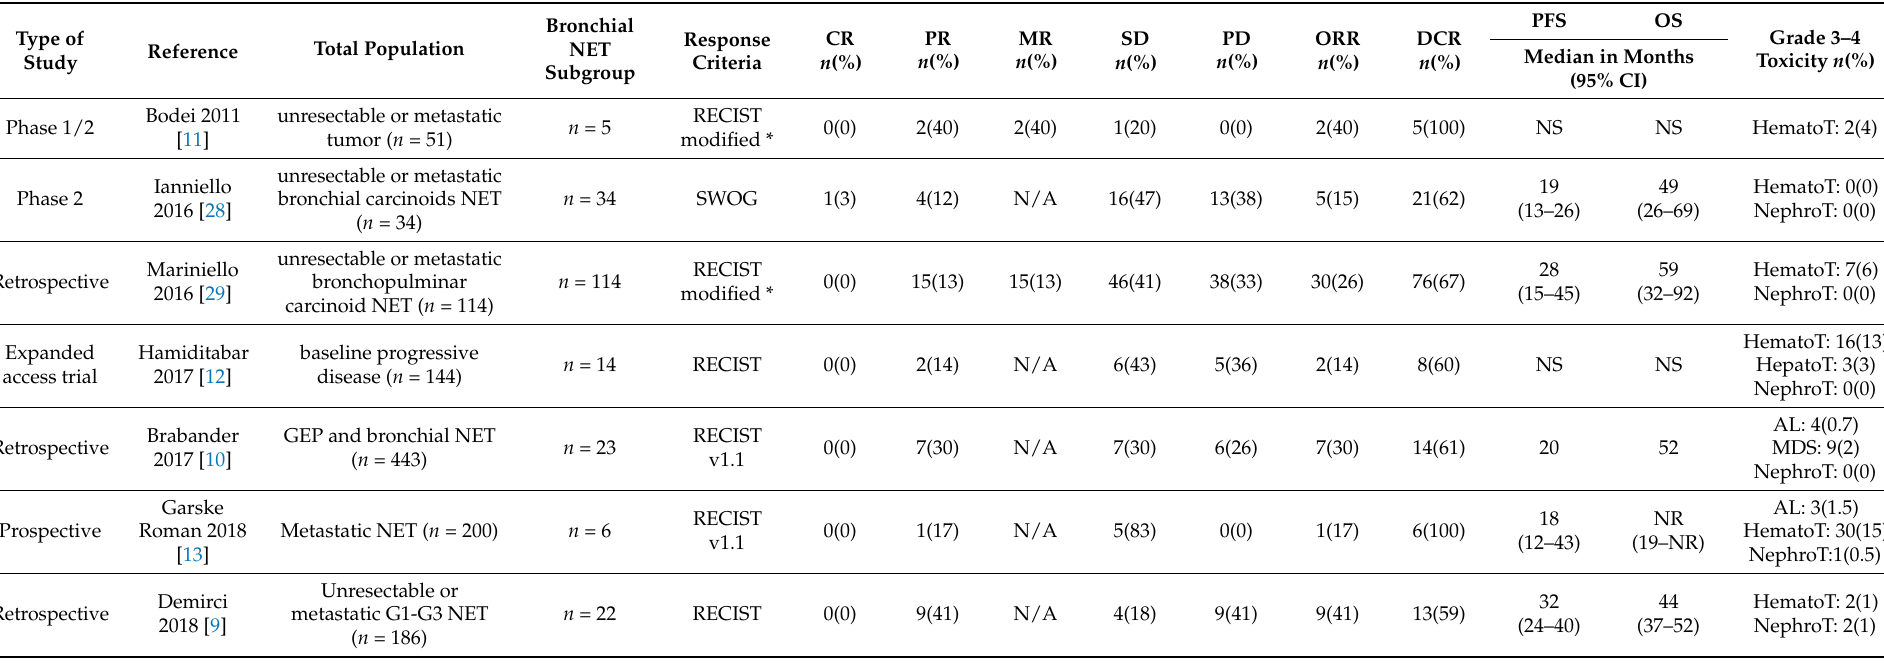
Table 3. Studies reporting 177 Lu-DOTATATE PRRT efficacy and tolerance in bronchopulmonary